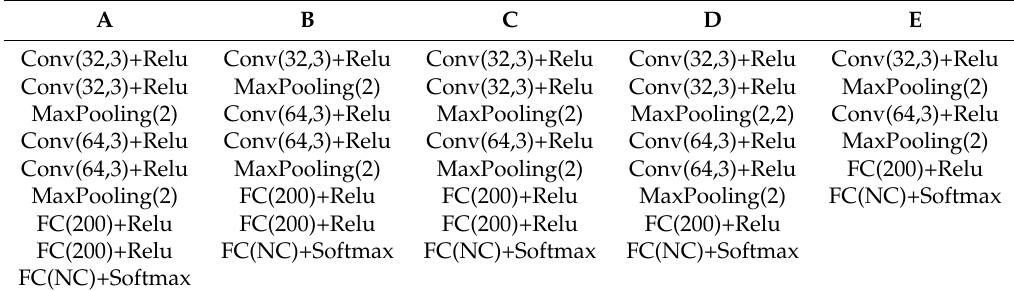
Table 1. Table of the architectures of substitute models. Here, the Conv and Relu are convolution layer and the Relu activation function, FC means the fully connected layer, and Softmax is the last layer of CNN classification model. Notice that the NC in Softmax layers is the number of the classes that the target dataset